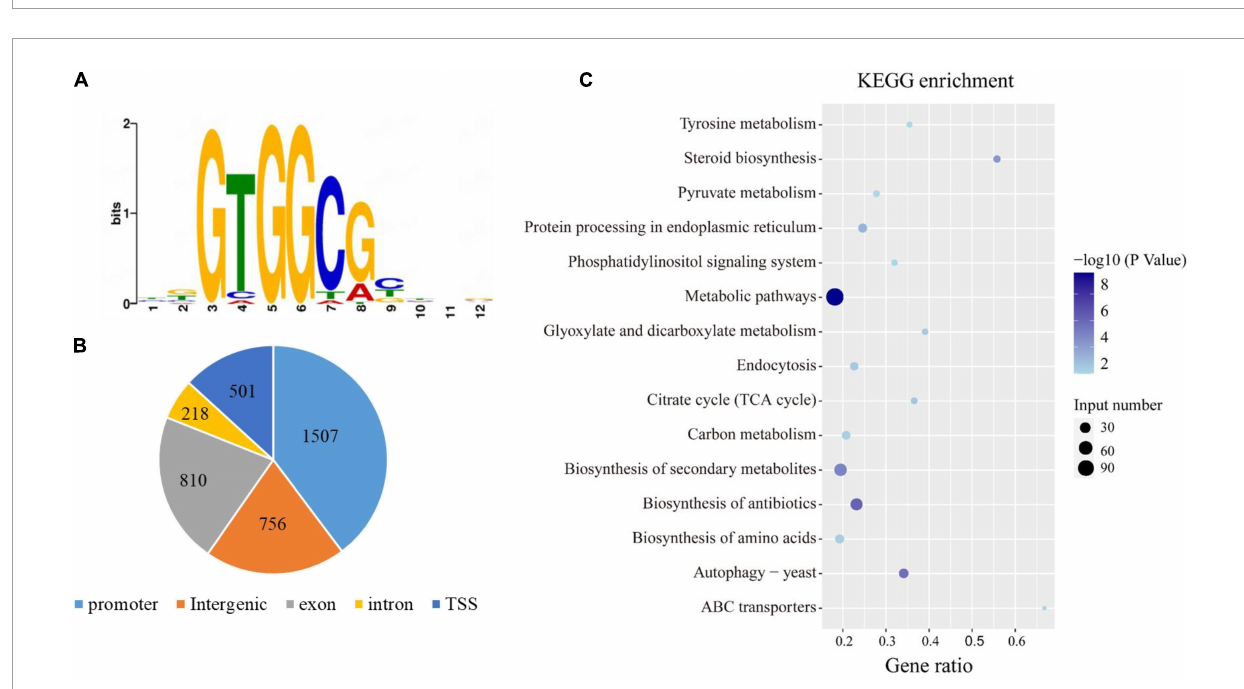
FIGURE3 Genome-Wide Identification PuCRZ1 target genes by DNA affinity purification sequencing. (A) P. umbellatus DNA motifs bound by PuCRZ1 protein in DAP-seq. (B) Distribution of the PuCRZ1 binding sites in the P. umbellatus genome. (C) KEGG annotation of targeted genes bound by PuCRZ1